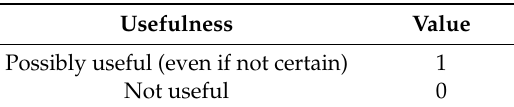
Table 3. Usefulness